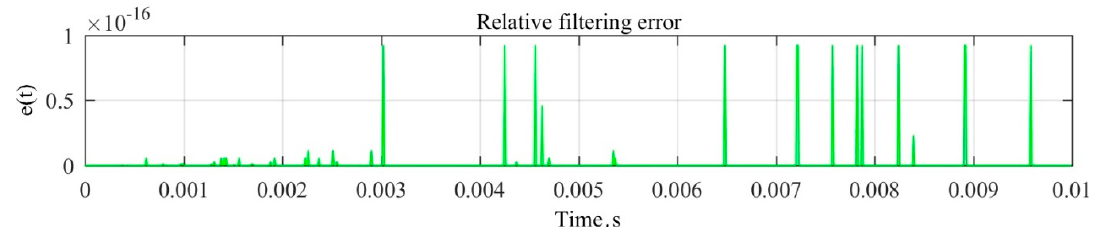
Figure 7. The comparison of filtering error for RNS filter and positional filter.